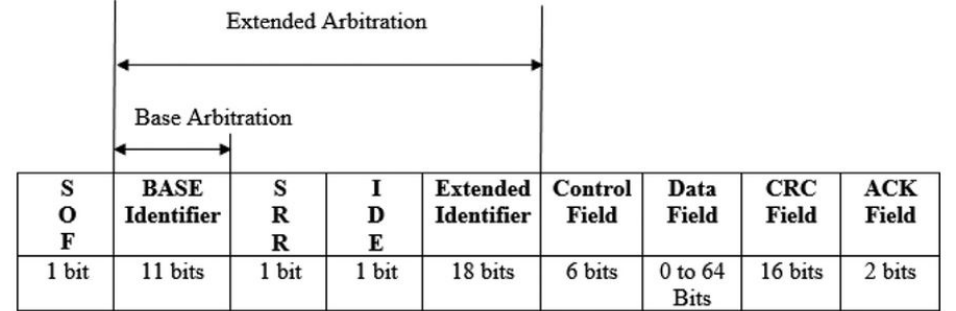
Figure 4. The standard CAN frame format [adopted from [8]].